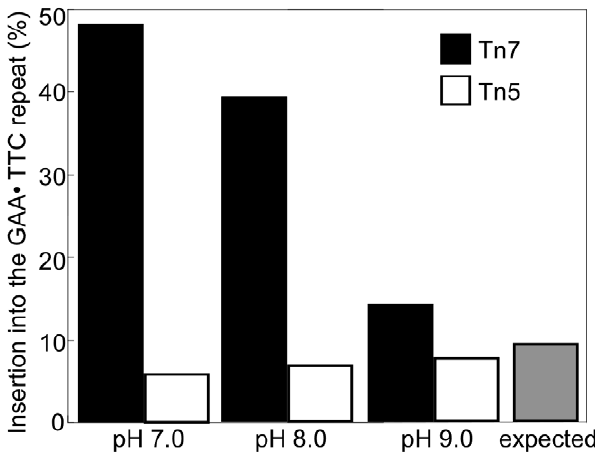
Figure 2. Preferential insertion into the (GAA N TTC) 108 repeat by Tn7 is pH dependent. Bars indicate transposon insertion into the (GAA N TTC) 108 repeat as a percentage of total insertions in the target plasmid at several pH values. Transposon Tn7 (black bars) shows a pH dependent bias for insertion into the repeat, inserting 48, 39 and 14 percent of the time at pH 7, pH 8 and pH 9, respectively. In contrast, transposon Tn5 is not attracted to the GAA N TTC repeat, inserting 6, 7 and 8 percent of the time at pH 7, pH 8 and pH 9, respectively. Insertion location was determined by a combination of restriction digest mapping and DNA sequencing. The expected frequency based on target size is 9% (gray bar). For pH 7 and pH 9 n=96, for pH 8